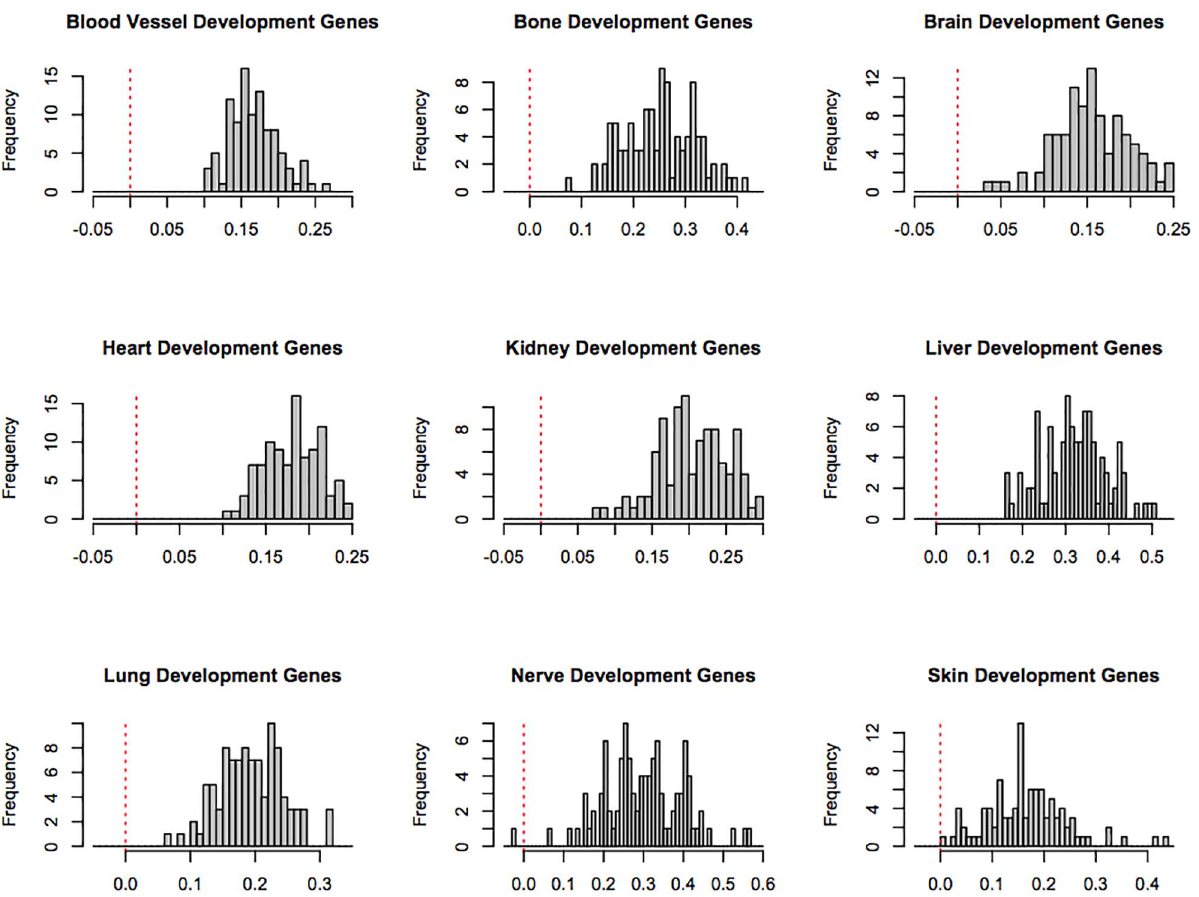
Figure 2. Histogram showing P pool - P trad for each query gene set. The red lines show a difference of zero; values to the left of these lines represent individual random trials in which the traditional method outperformed the pooling method. This occurred only once, in one trial for the skin development gene set.